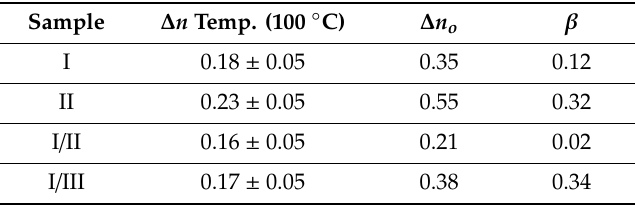
Table 5. The values of birefringence ∆ n (by using the MS technique at 543 nm), ∆ n o and β constant for all